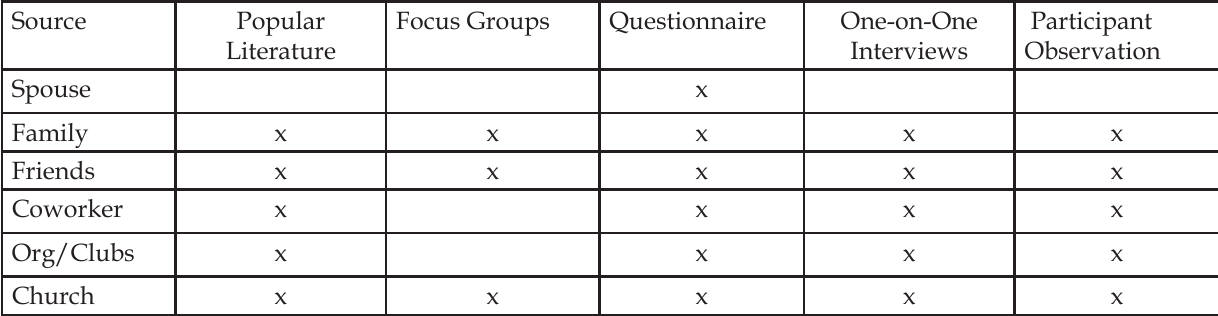
Table III. Sources of Social Support